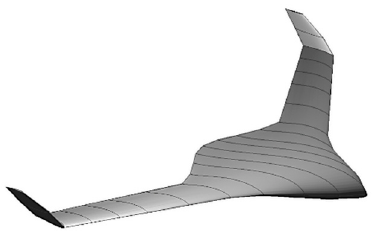
Figure 8. The reference BWB UAV aircraft configuration, modelled using XFLR5 3D.